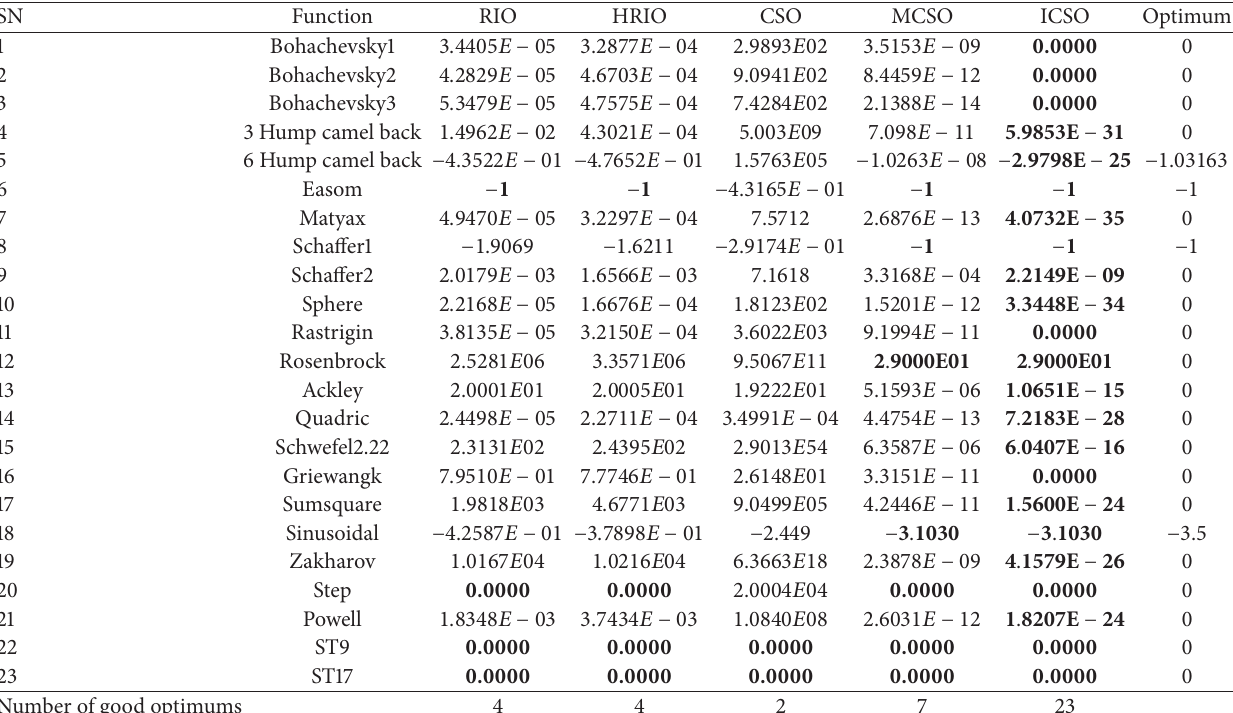
Table 5: Comparison of average performance of RIO, HRIO, CSO, MCSO, and ICSO. SN